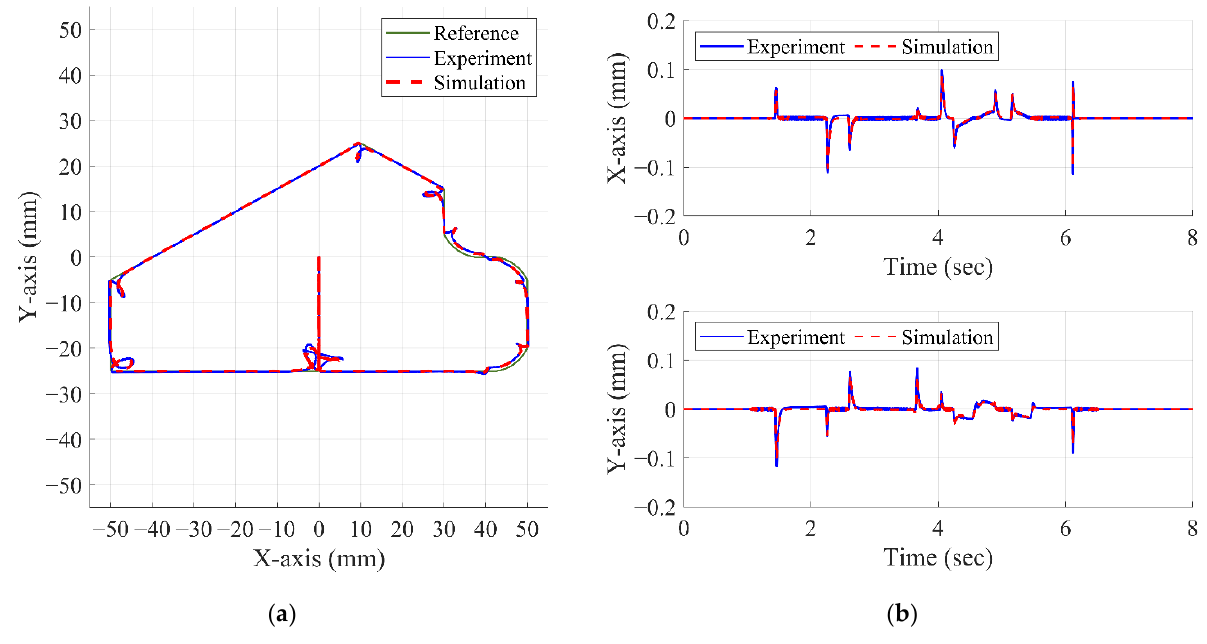
Figure 19. Comparison between measured and simulation result: ( a ) line–curve hybrid trajectory with 50 times the error; ( b ) x - and y -axis contour error.